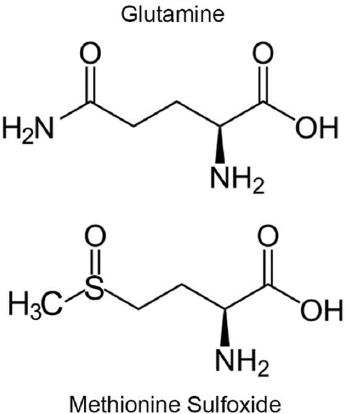
Figure 1. Glutamine is an analogue of methionine sulfoxide.